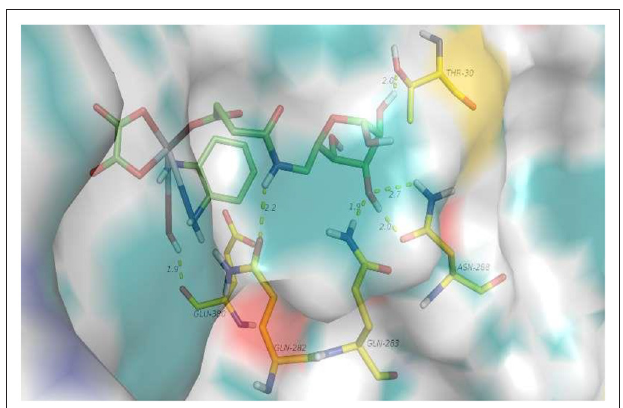
FIGURE 2 | 6d interacting with a variety of amino acid residues of GLUT1 (4PYP).